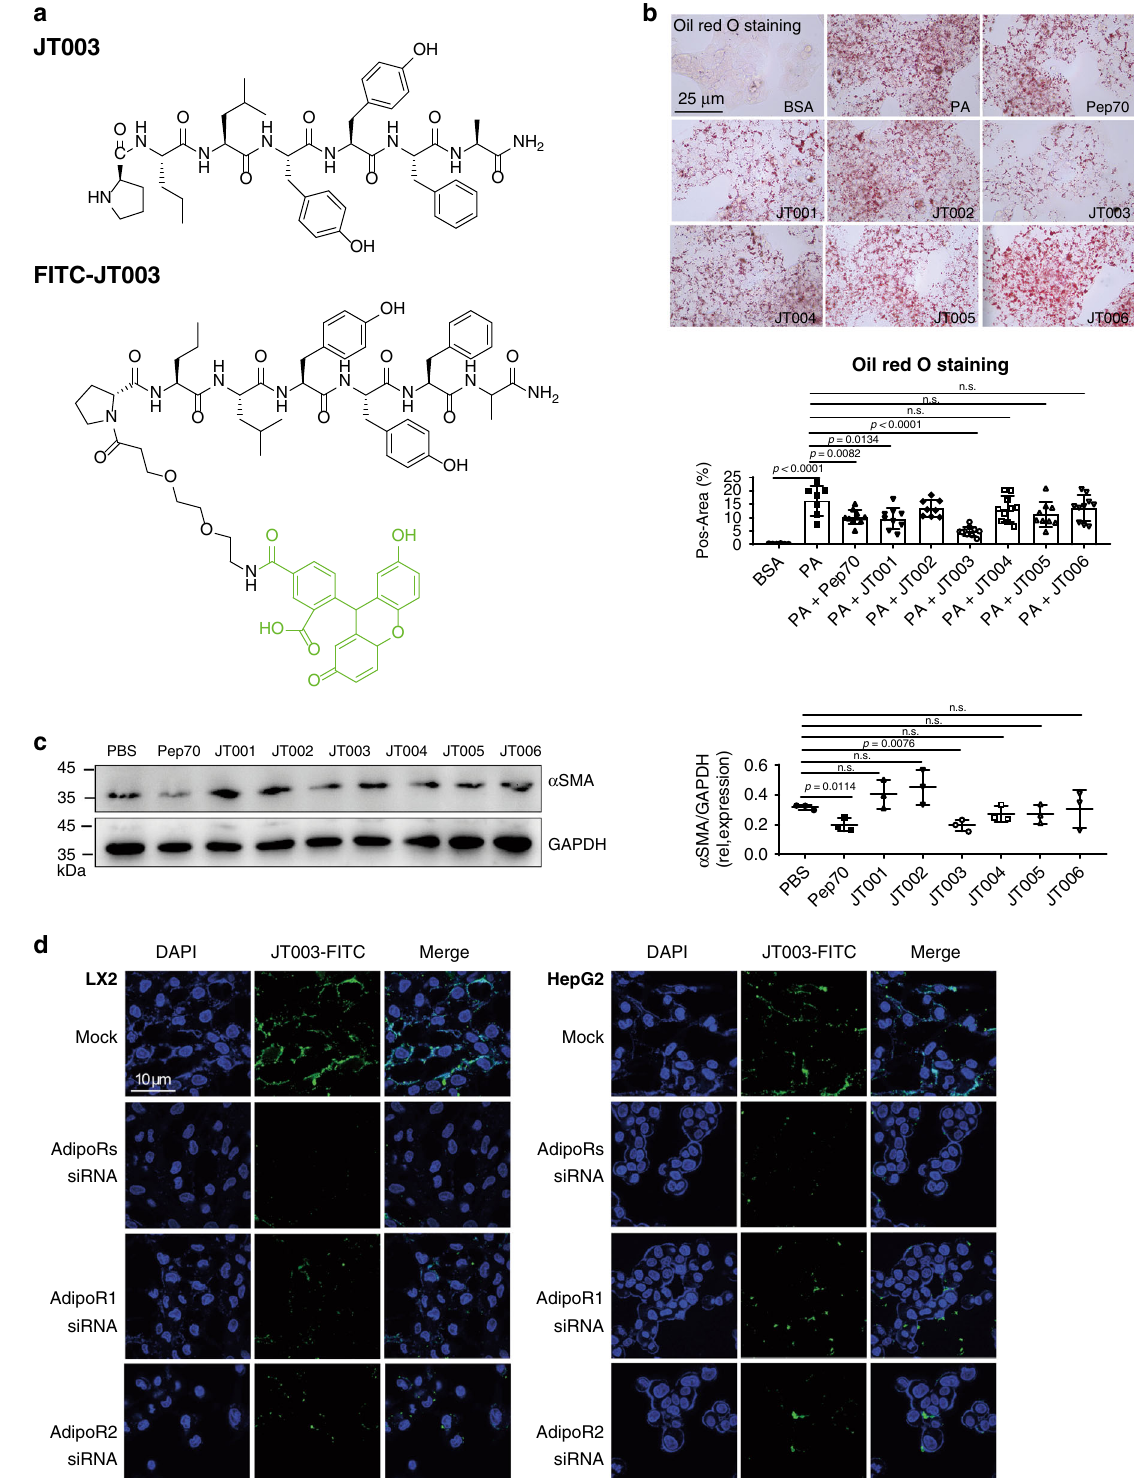
Fig. 1 Peptides design and activity study. a Chemical structures of JT003 and FITC-JT003. b Oil Red o staining of PA induced lipid accumulation in HepG2 cell line after treated with 200 μ M peptides. Triplicates were performed. c Western blotting for α SMA expression in LX2 after peptides treated. Three separated experiments were performed. α SMA expression was normalized to that of GAPDH. Positive areas were analyzed with ImageJ. d HepG2 and LX2 cells were incubated with FITC-JT003 at 37 °C for 2 or 4 h. The nucleus was stained with Hochest33342. The green channel represents as FITC. For each experiment, triplicates were performed. For in vitro experiment, the concentration of JT003 is 200 μ M. Here and later, for each assay, three separated experiments were performed. And for each experiment ( n = 4 cell samples/group or n = 6 mice/group). For the in vivo experiment, the dose of JT003 is 500 μ g kg − 1 . All the above data are presented as mean values ± SEM using unpaired Student ’ s t test. Source data are provided as a Source Data fi